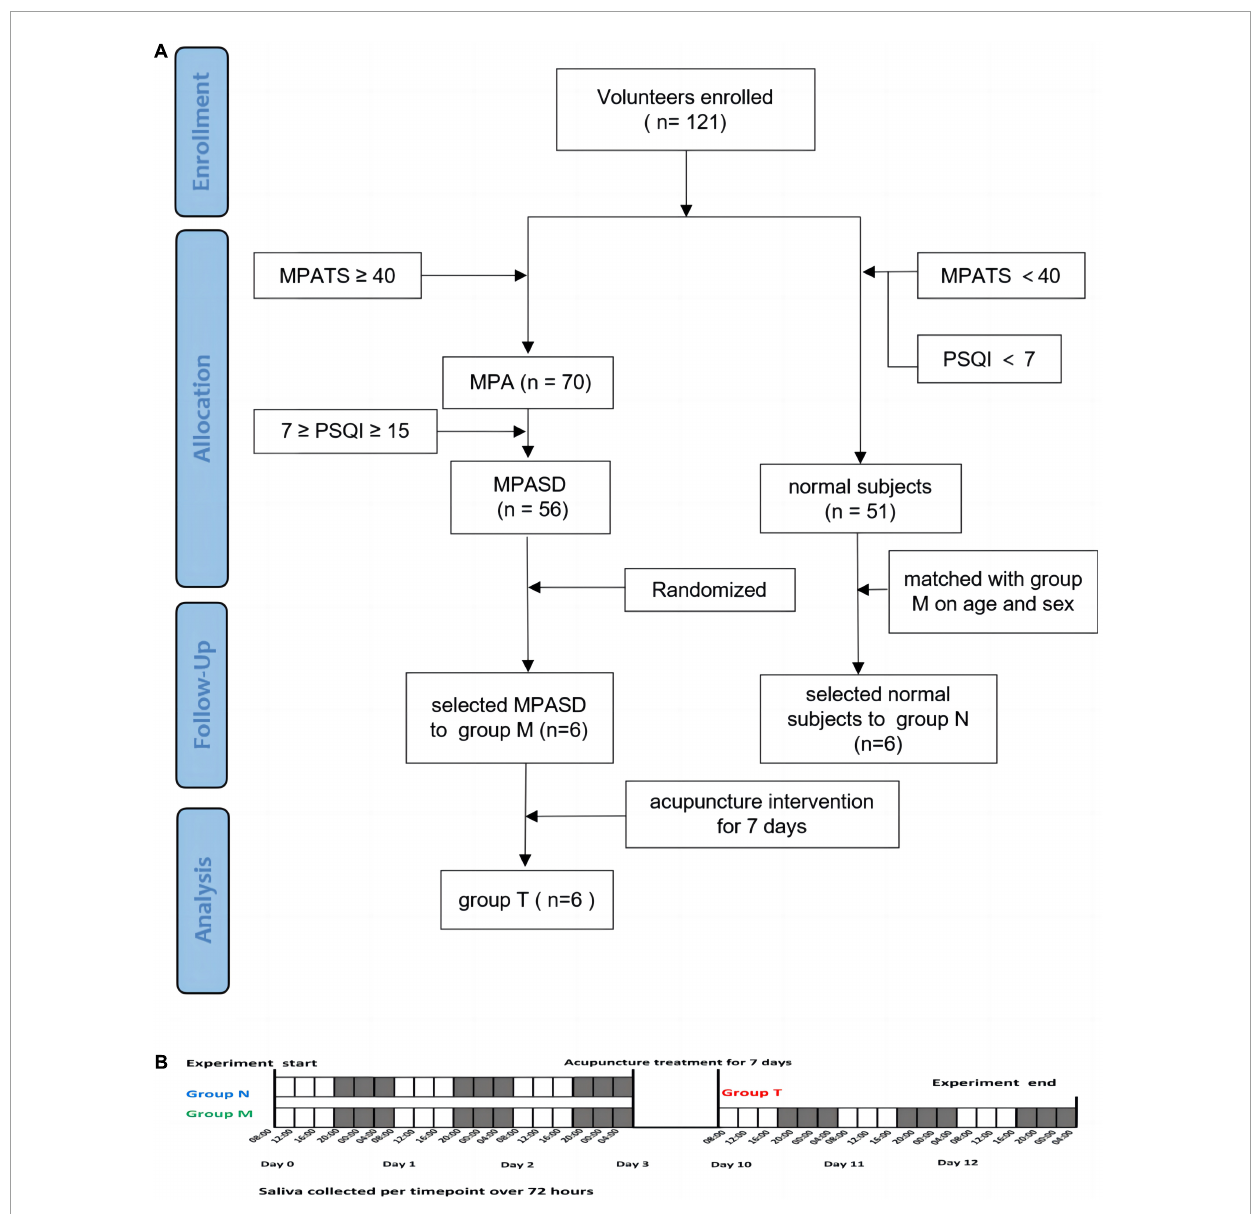
FIGURE1 Schematic diagram of group enrollment and sample collection. Flow chart of the experimental design (A) . Saliva collection protocol (B) .